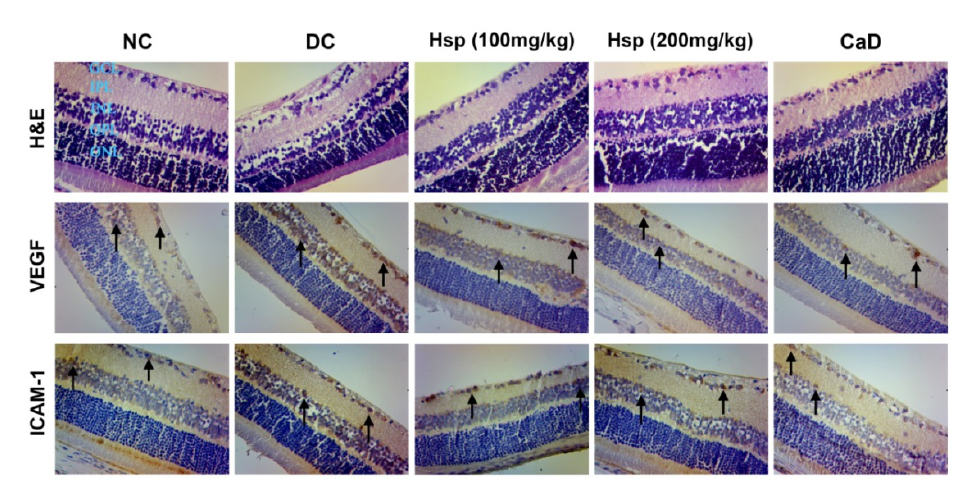
Figure 5. The effects of Hsp and CaD on morphological changes of retinas and expression of VEGF and ICAM-1 in diabetic rat retinas (SP ×